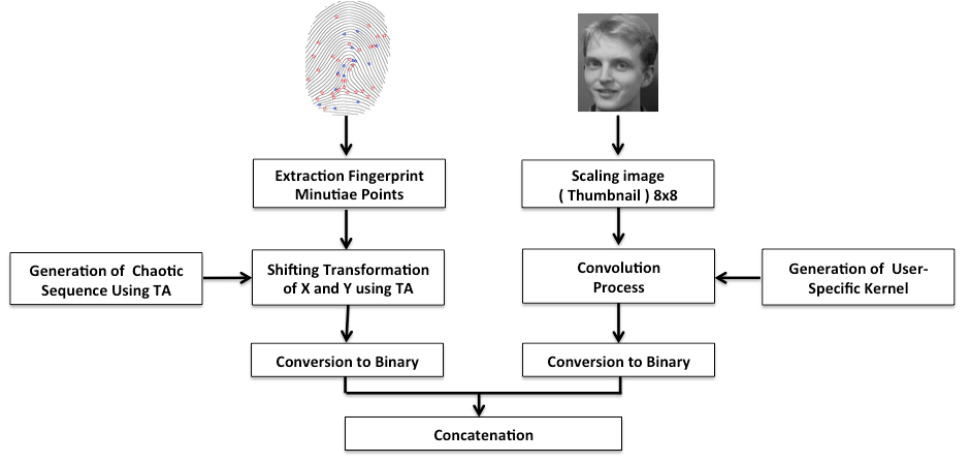
Figure 1. Proposed cancelable approach architecture (enrollment